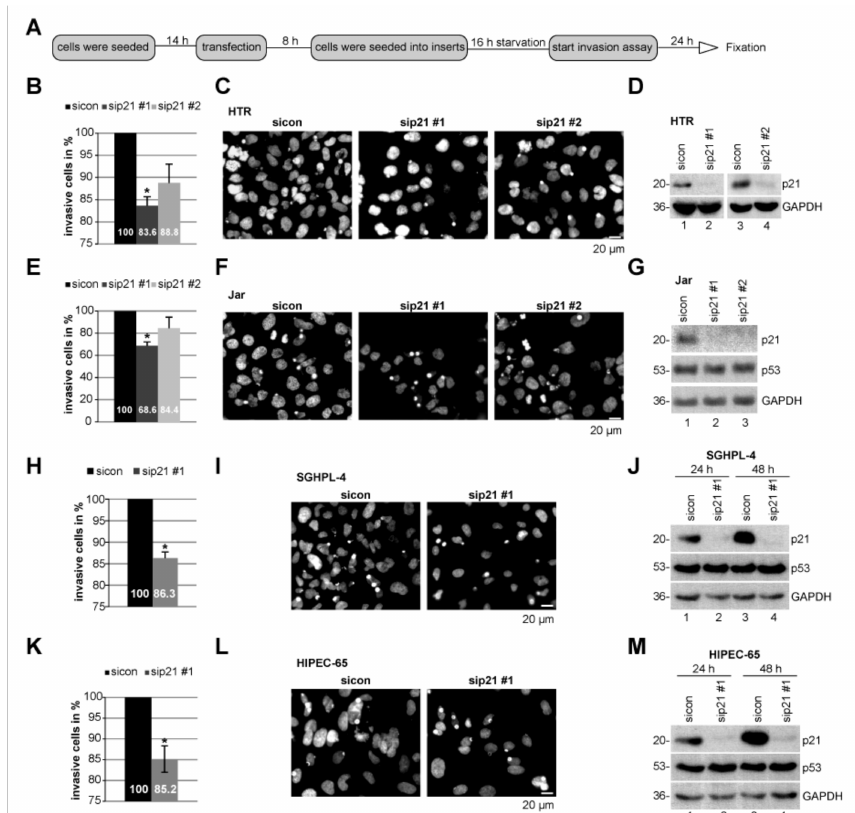
Figure 4. The invasion capacity is impaired in cells with reduced p21 levels. ( A ) Schedule of invasion assay. Di ff erent cell lines were treated with control small interfering RNA (siRNA) (sicon) or two distinct siRNA against p21 (sip21 #1 or #2). ( B ) Quantification of invaded HTR cells. The total number of invaded cells in the control group was assigned as 100%. ( C ) Representatives of invaded HTR cells are shown. Scale bar: 20 µ m. ( D ) Control Western blot analysis showing the e ffi cient knockdown of endogenous p21 in HTR cells. Glyceraldehyde-3-phosphate dehydrogenase (GAPDH) served as loading control. ( E ) Quantification of invaded Jar cells. ( F ) Representatives of invaded Jar cells are shown. Scale bar: 20 µ m. ( G ) Control Western blot analysis of Jar cells. GAPDH served as loading control. ( H ) Quantification of invaded SGHPL-4 cells. ( I ) Representatives of invaded SGHPL-4 cells are shown. Scale bar: 20 µ m. ( J ) Control Western blot analysis of SGHPL-4 cells. GAPDH served as loading control. ( K ) Quantification of invaded HIPEC-65 cells. ( L ) Representatives of invaded HIPEC-65 cells. Scale bar: 20 µ m. ( M ) Control Western blot analysis of HIPEC-65 cells. GAPDH served as loading control. The results from each cell line are presented as mean ± standard error of the mean (SEM) from three independent experiments. * p <